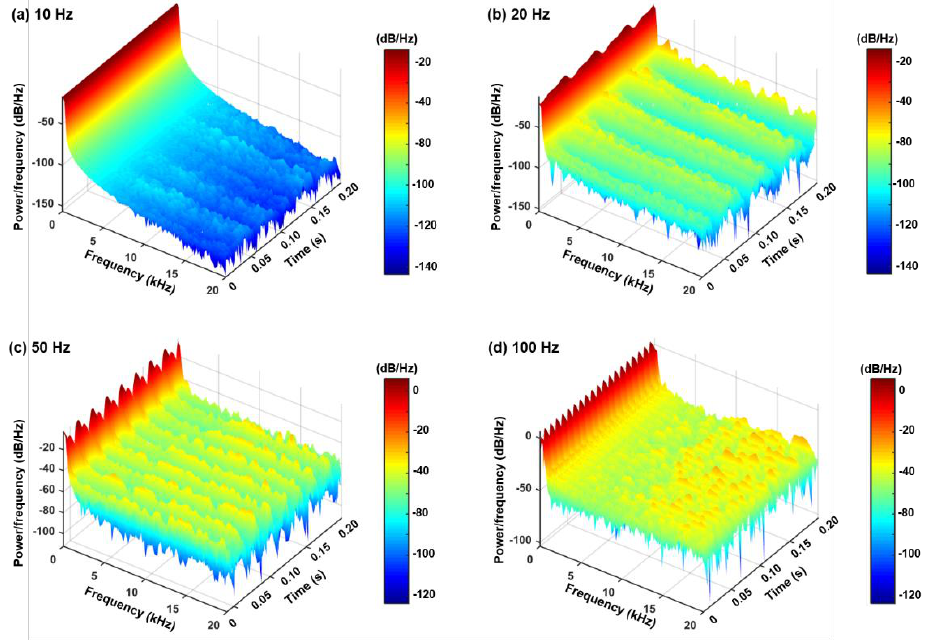
Figure 10. Waterfall spectrogram of the sound pressure signals at different glottal vibration frequen- cies: ( a ) 10 Hz, ( b ) 20 Hz, ( c ) 50Hz, and ( d ) 100 Hz.